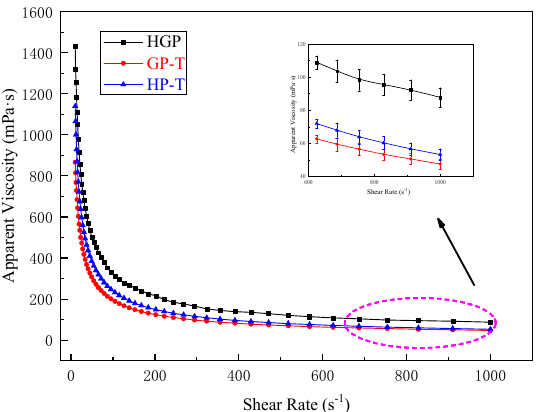
Figure 11. Apparent viscosity relative to shear rate of the HGP, GP-T, and HP-T at 0.6